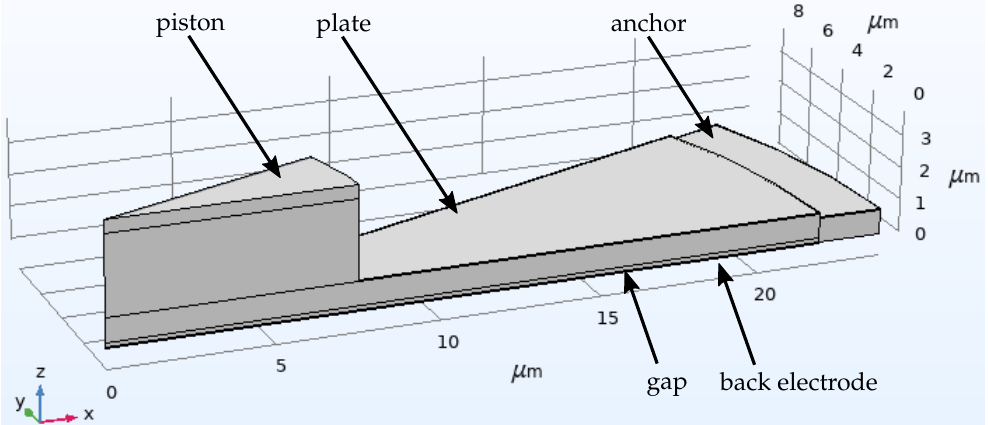
Figure 3. Model geometry in COMSOL. The 3D model uses rotational symmetry on a pie piece of 20 ◦ .